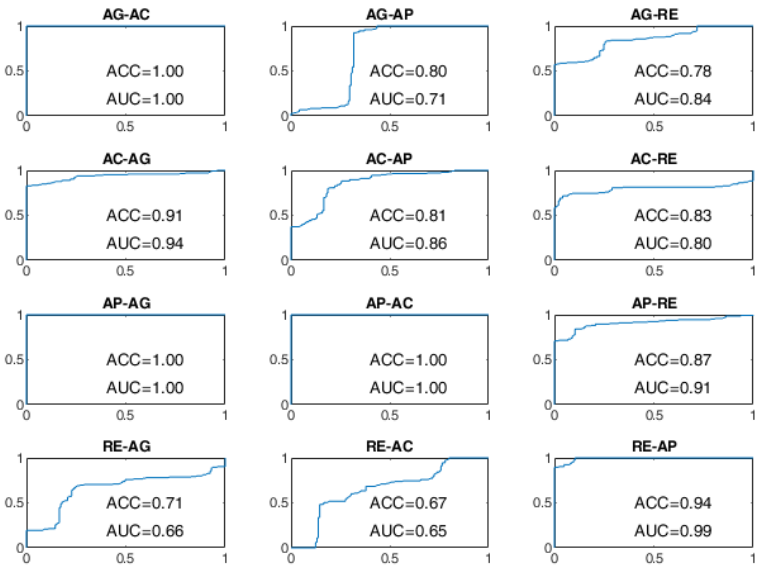
Figure 11 . ROC curves of the BLSTM-AE approach on the DS1 dataset for WD = 70 s.